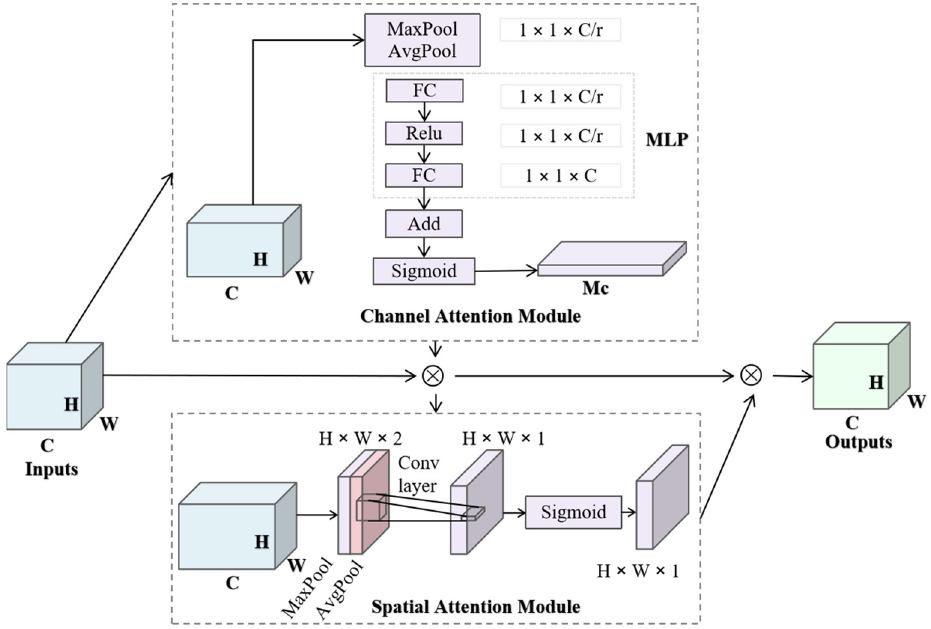
Figure 4. Convolutional block attention